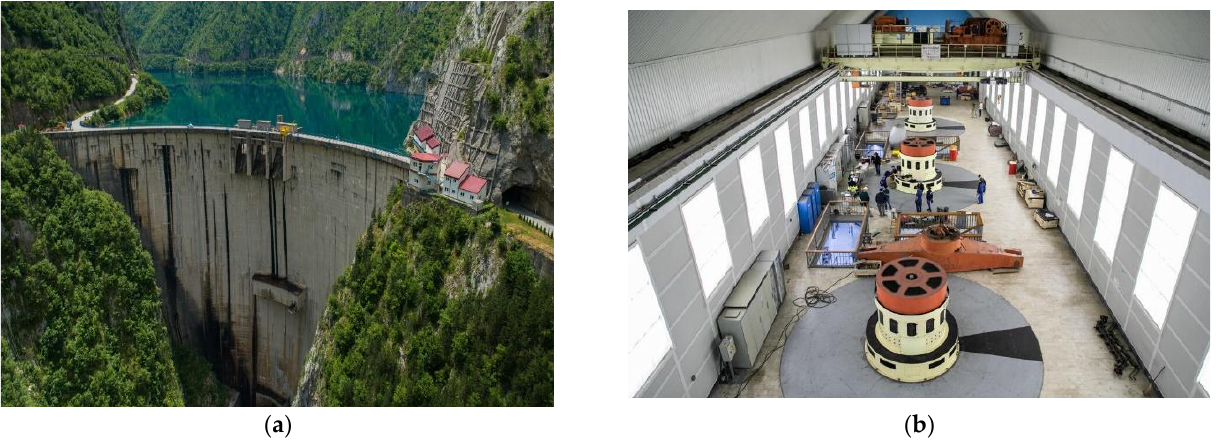
Figure A1. The HPP and the generators in HPP Piva where the experiments were conducted: ( a ) HPP Piva and ( b ) generators in HPP Piva, Montenegro.